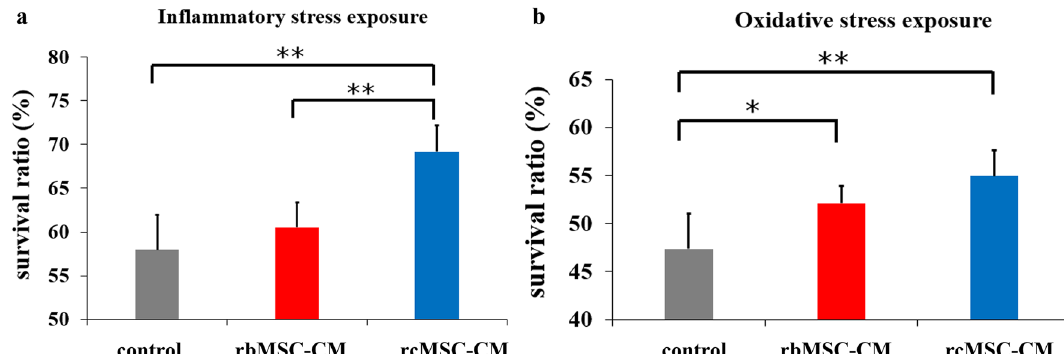
Figure 6. Effects of conditioned medium on the survival rate of stress-exposed NG108-15 cells. Survival rates of NG108-15 cells exposed to inflammatory stress ( a ) and oxidative stress ( b ). Data are presented as the mean ± SD of independent experiments (* P < 0.05 and ** P < 0.01, respectively, n =